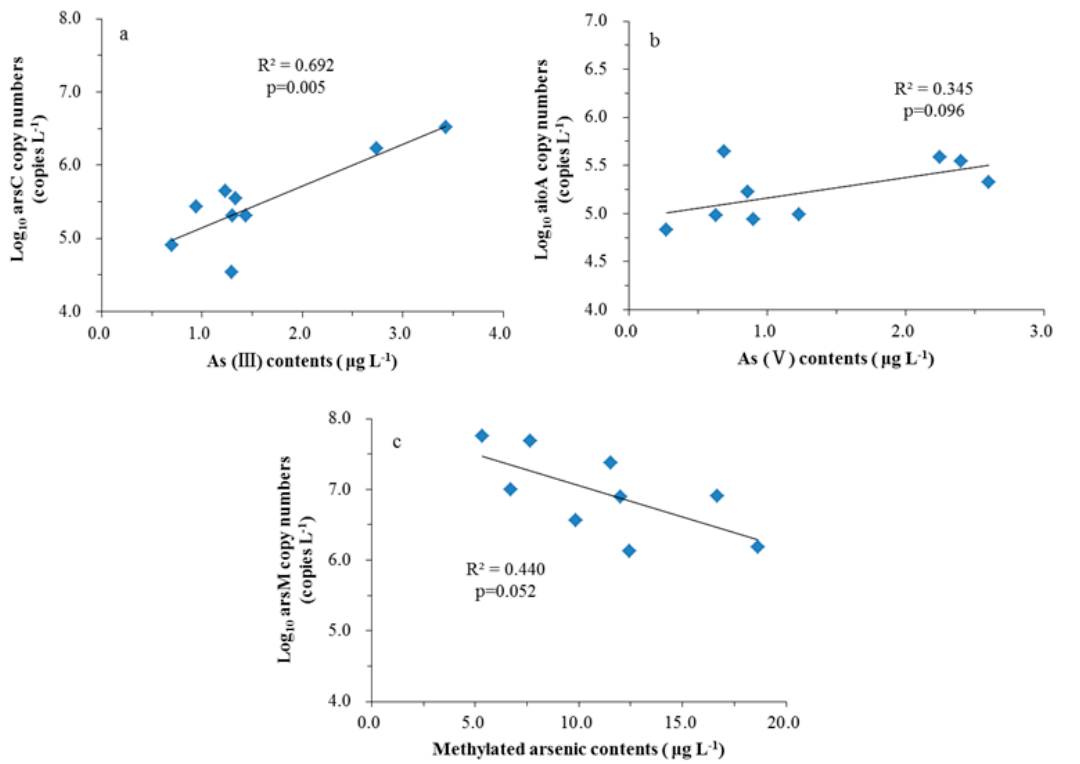
Figure 3. Correlation analyses between different As species concentration vs. As metabolism gene copy numbers. ( a : As(III) contents vs. arsC gene; b : As(V) contents vs. aioA gene; c : Methylated As contents vs. arsM gene).